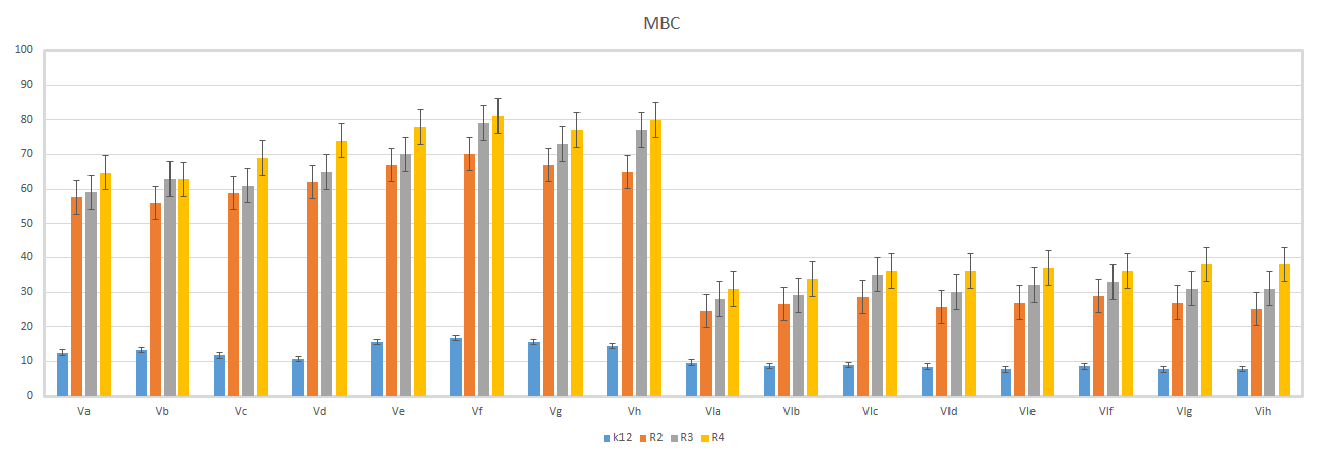
Figure 4. Minimum bactericidal concentration (MBC) of the phosphonate derivatives. The x -axis features compounds Va–Vh and VIa–VIh used sequentially. The y -axis shows the MIC value in μ g/mL − 1 . Investigated strains of E. coli K12 as control (blue), R2 strains (orange), R3 strain (grey), and R4 strain (yellow). The y -axis shows the MBC value in µ g/mL − 1 . The order in which the compounds were applied to the plate is shown in Supplementary Materials Figure S1.